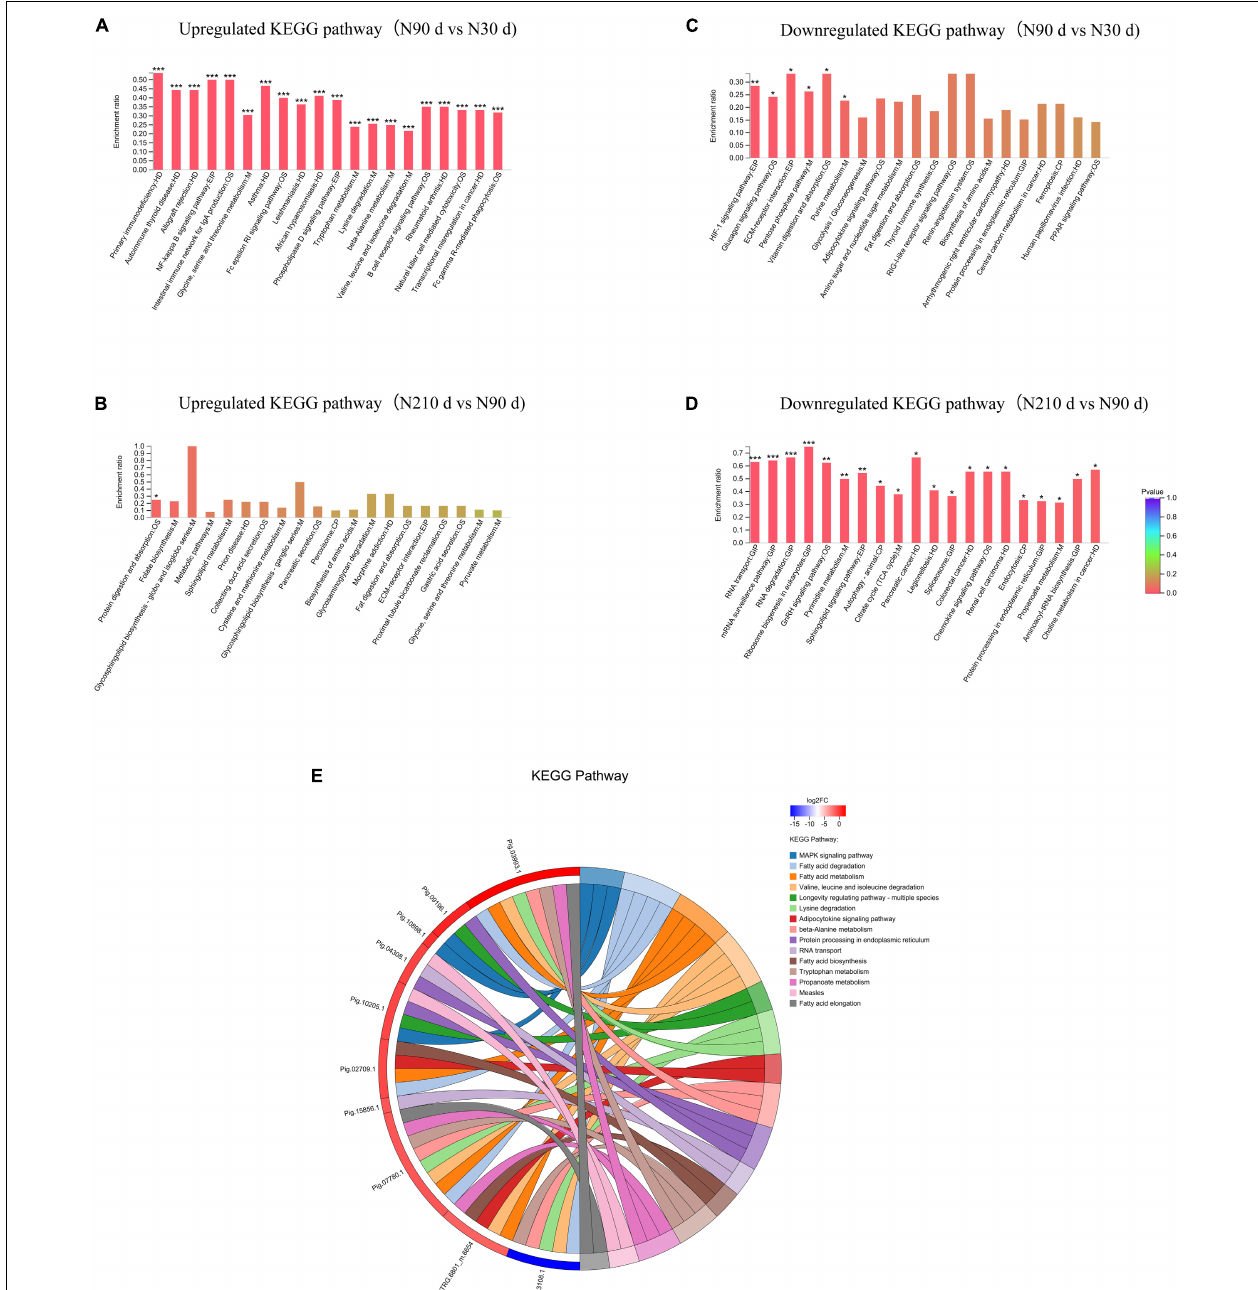
FIGURE 4 | Kyoto Encyclopedia of Genes and Genomes analysis of DEPs in the N90 vs. N30 d and N210 vs. N90 d groups. (A) Upregulated KEGG analysis of DE proteins in the N90 vs. N30 d group. (B) Upregulated KEGG analysis of DE proteins in the N210 vs. N90 d group. (C) Downregulated KEGG analysis of DE proteins in the N90 vs. N30 d group. (D) Downregulated KEGG analysis of DE proteins in the N210 vs. N90 d group. The top 20 enriched KEGG pathways ranked by P -values are shown. * P < 0.05, ** P < 0.01, *** P < 0.001. (E) Chord diagram of overlapped DEPs enrichment.